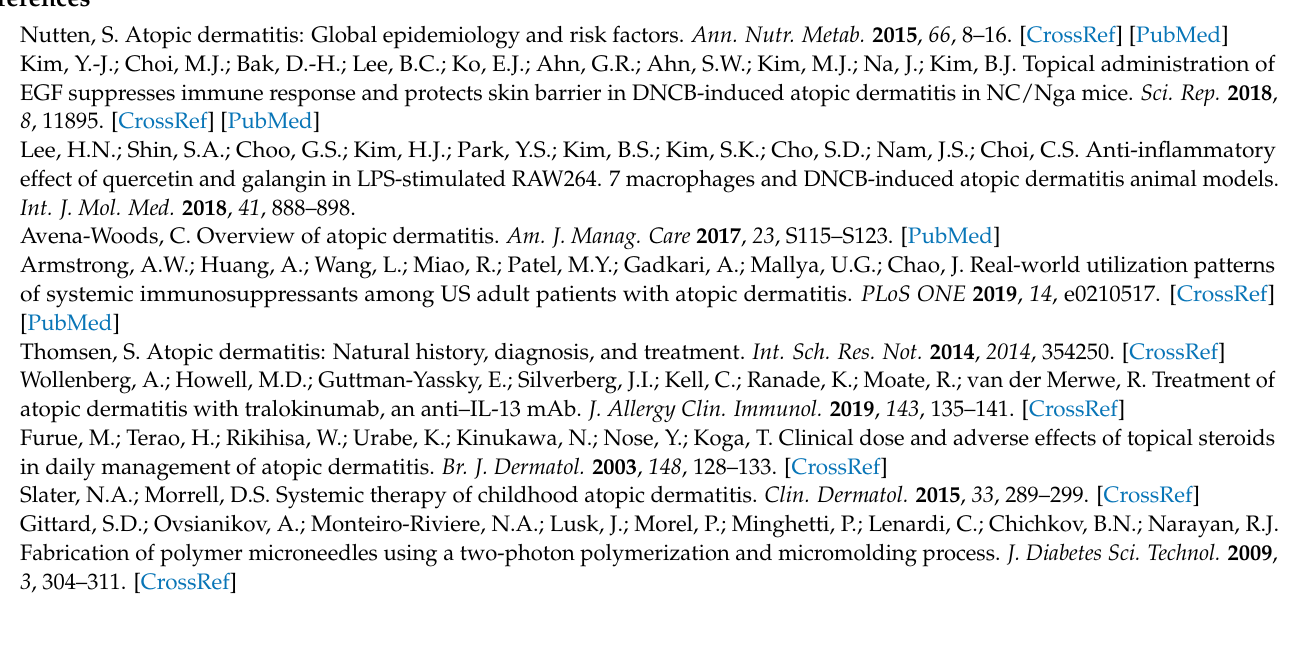
Figure S4: Representative image of MNs placed side by side in the center of the lesion (Not treated, day